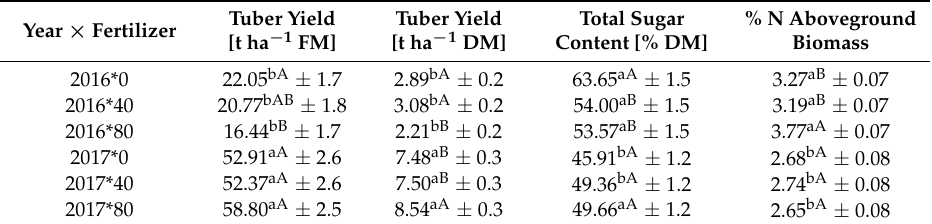
Table A4. Results of a multiple t-test at significance level of 5% after finding significant differences via global F-test for the factor year × fertilizer. Same lowercase letters indicate no significant differences between the years and same fertilization level. Same capital letters indicate no significant differences between the fertilization levels within one year.